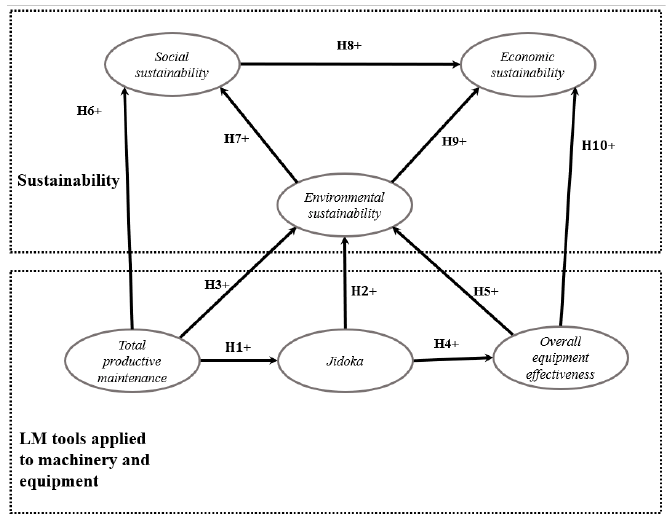
Figure 1. Proposed model of the relationships between LM tools and sustainability.